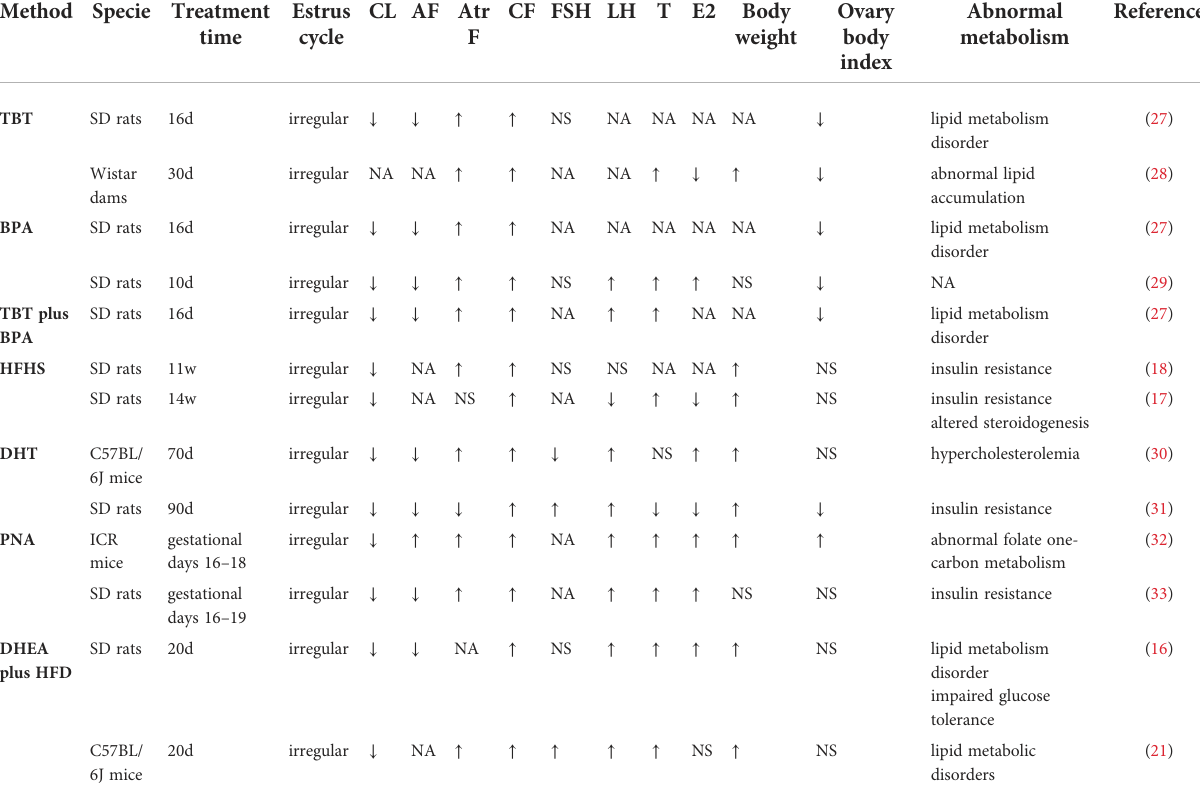
TABLE 2 Information about the eight groups PCOS animal models. Method Specie